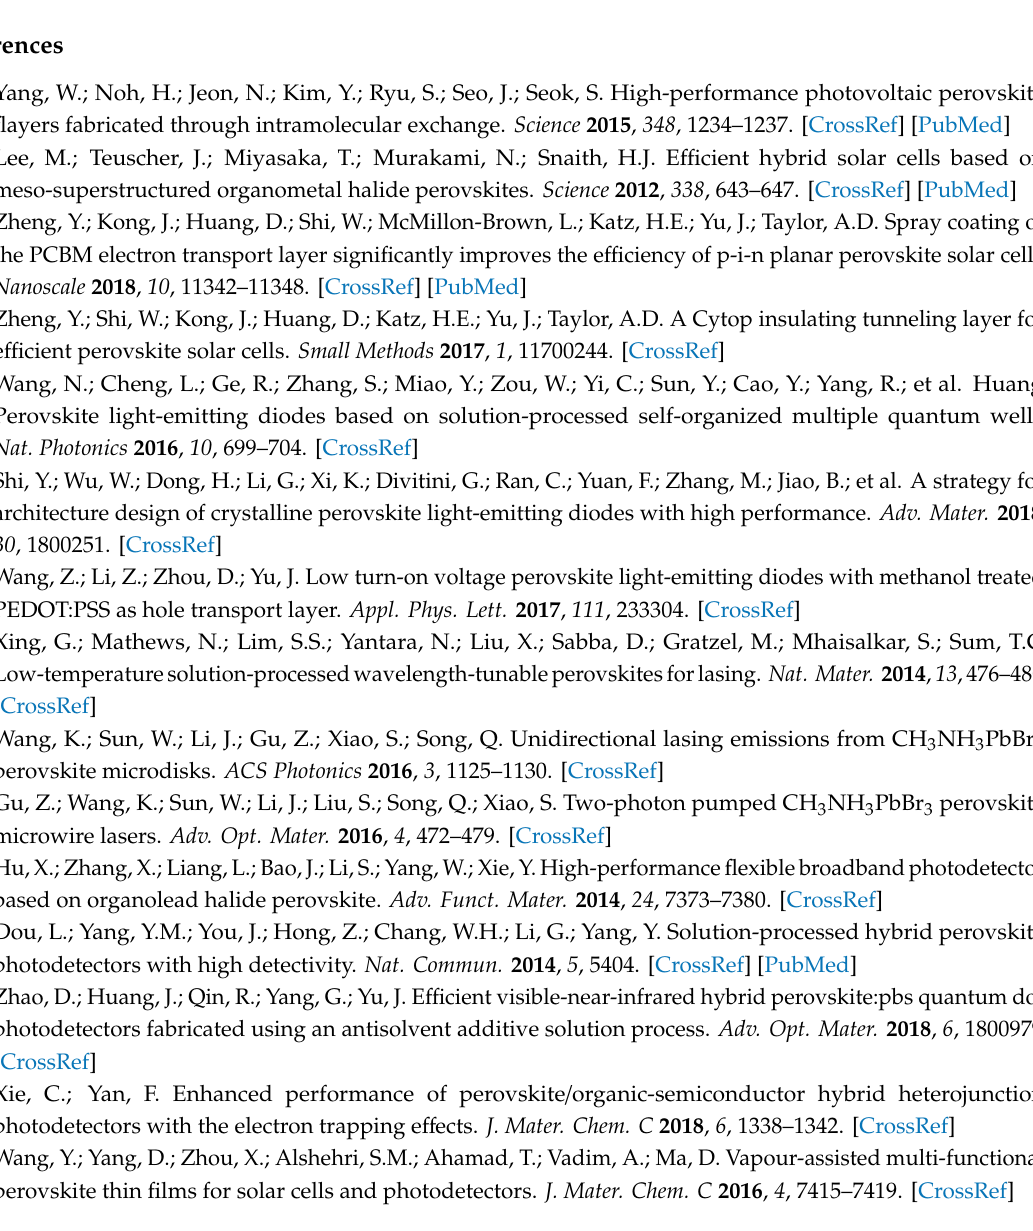
Figure S1: (a) Semilog J-V characteristics, (b) On / o ff current radio (c) Measured EQE spectra and (d) Calculated D* values at − 0.1 V of PePDs with various concentrations of BPTCD additive (e) Calculated responsivity values − 0.1 V of PePDs with various concentrations of BPTCD additive., Figure S2: SEM images of perovskite film with di ff erent concentrations of BPTCD additive, Figure S3: AFM measurement of perovskite films with 3% BPTCD and without